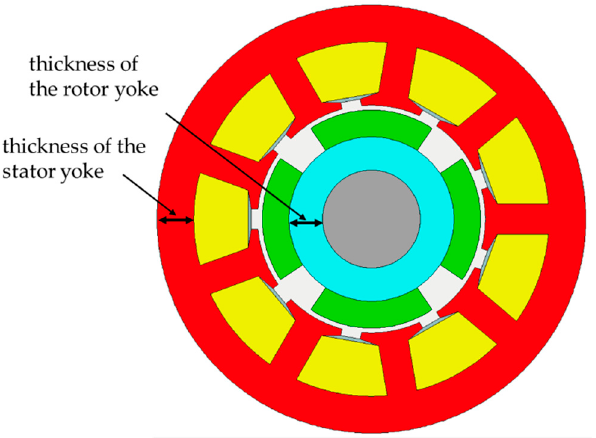
Figure 1. Structure diagram of the surface-mounted permanent magnet synchronous motor.